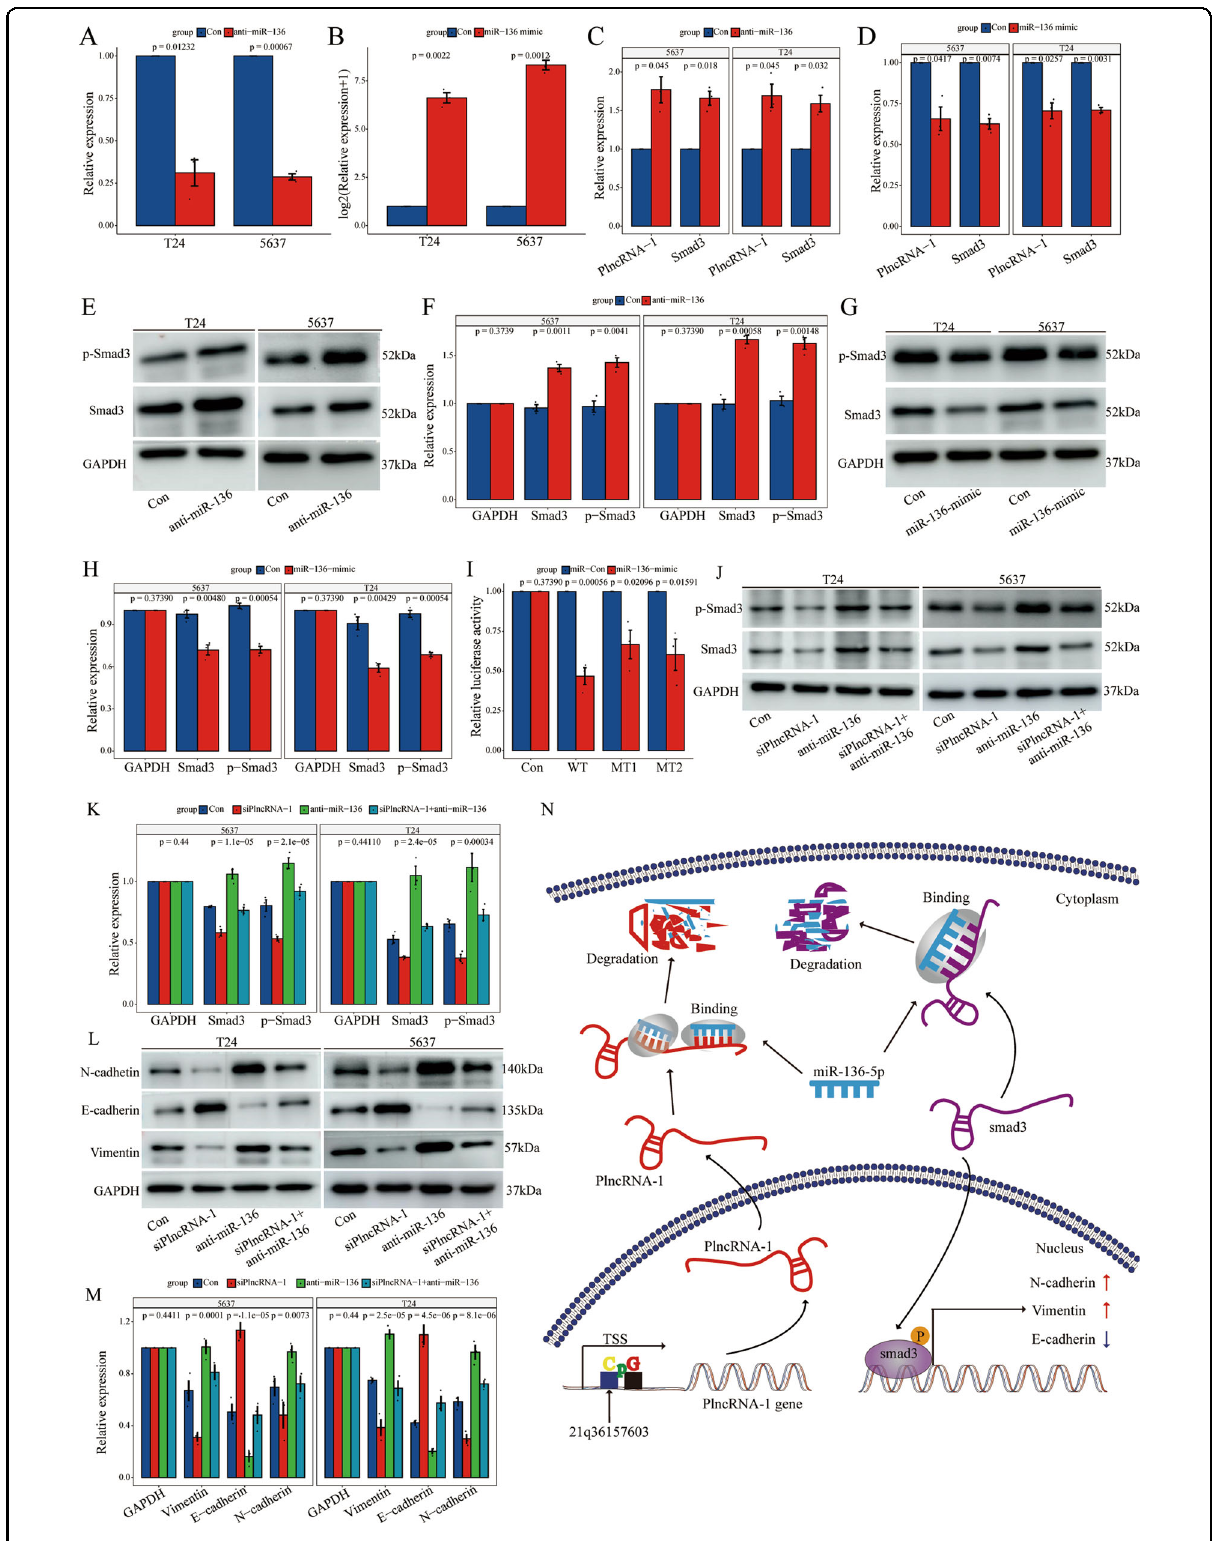
Fig. 7 (See legend on next